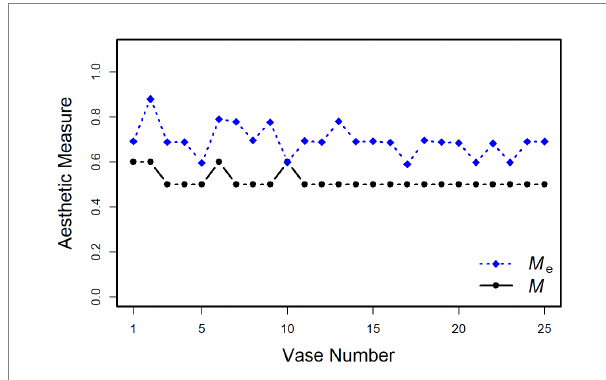
FIGURE 3 Birkhoff’s aesthetic measure M and Staudek’s extended version M e applied to our 25 vase